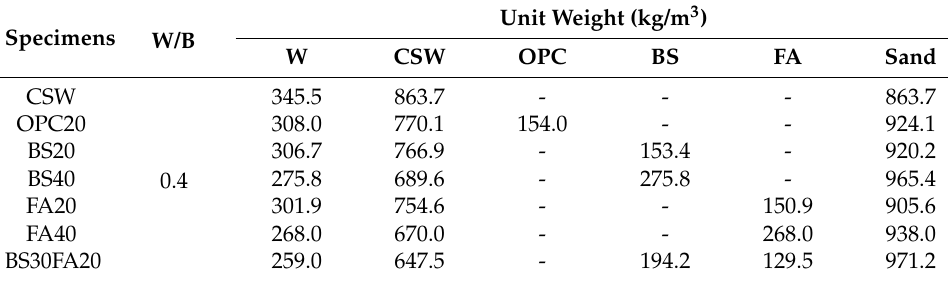
Table 5. Mixture proportion—mortar 1:1.